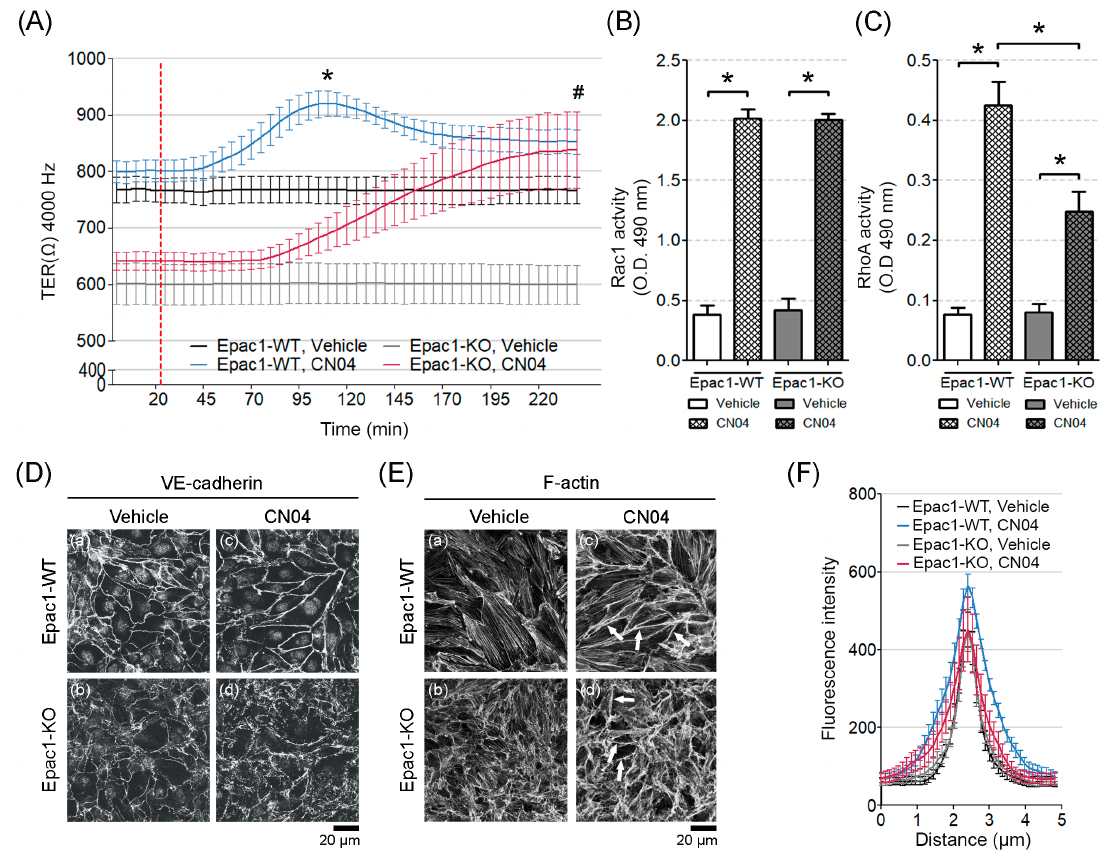
Figure 6. E ff ects of simultaneous activation of Rac1 and RhoA on TER, GTPase activation, VE-cadherin and F-actin distribution. ( A ) After achieving a stable TER, the cells monolayers were administered with a CN04 mediator (segmented red line). Measurements for the respective controls were performed in parallel. Barrier resistance was monitored; N = 4–5, n ≥ 8; “*” denotes statistical significance for the WT-Vehicle vs. WT-CN04; “#” for the KO-Vehicle vs. KO-CN04. ( B ) Rac1 G-LISA activation assay in WT and the Epac1-KO cell lines subjected to DMSO or CN04; N = 7; * p ≤ 0.05. ( C ) RhoA G-LISA activation assay in the WT and KO cell lines exposed to DMSO or CN04; N = 6; * p ≤ 0.05. ( D ) VE-cadherin immunostaining from the confluent control (a and b) or the CN04-treated (c and d) cell monolayers; N = 4. ( E ) E ff ect of Rho GTPases on F-actin remodeling in the control (a and b) and the CN04-treated (c and d) confluent cell sheets. Arrows indicate cortical actin; N ≥ 4. ( F ) The intensity of VE-cadherin staining was quantified by densitometric measurements; N = 4; n ≥ 25 cells per